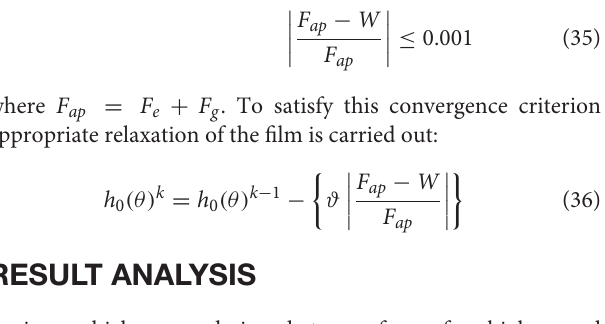
25 m/s). (B) Compression ( θ c 250 ◦ , P com 95 bar, η 0 0.004Pa.s, U = = = = 620 ◦ , P com 5 bar, η 0 0.004Pa.s, U 25 m/s). = = = =